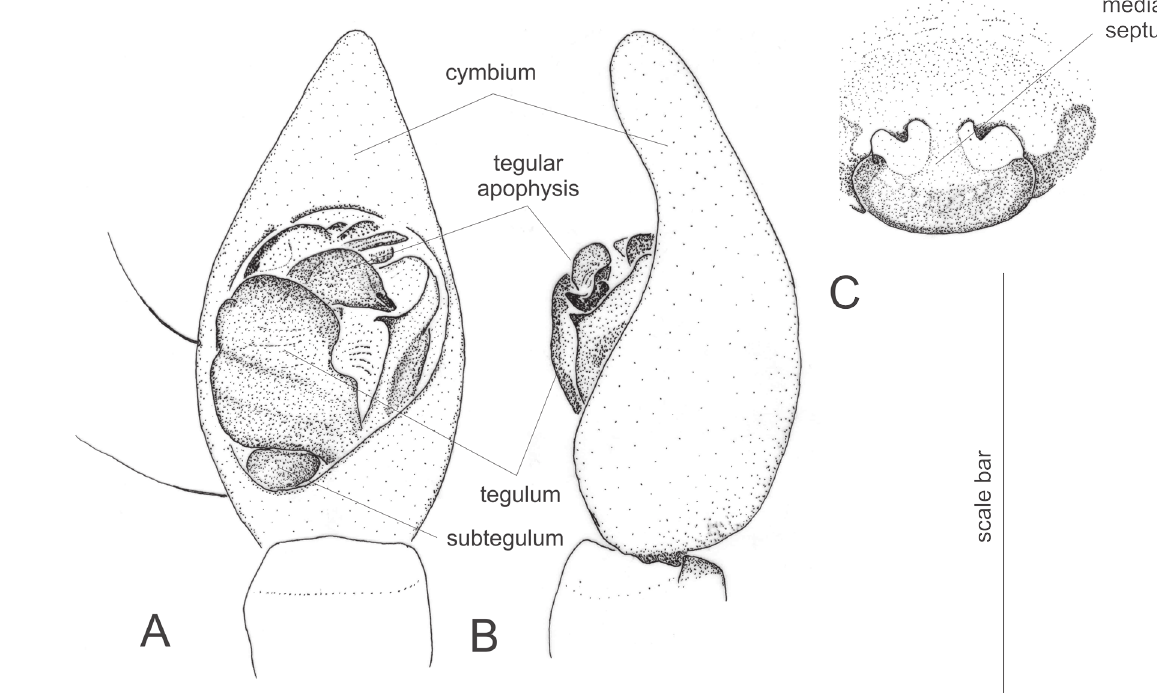
Fig. 20. Tetralycosa rebecca sp. nov., ♂, holotype (SAM NN21913) and ♀, paratype (SAM NN21914). A–B . Left male pedipalp, ventral and retrolateral view. C . Female epigyne, ventral view. Scale bar: A–B = 1.68 mm; C